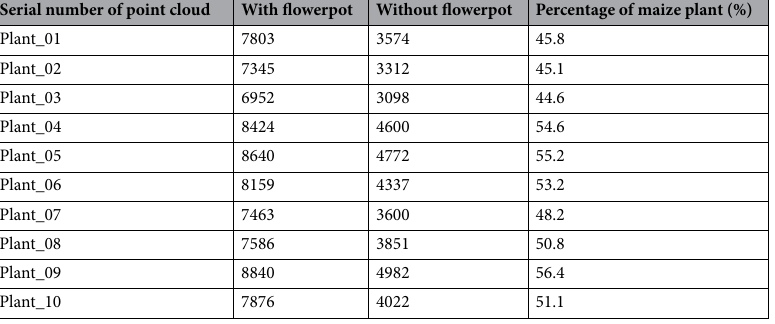
Table 1. Percentage of maize